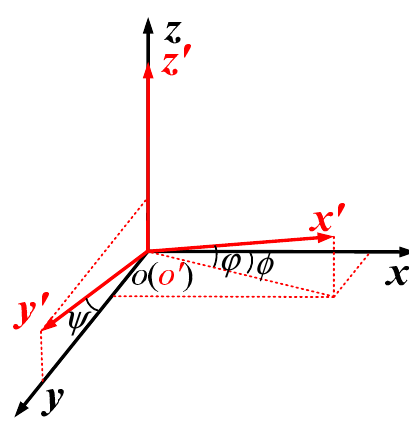
Figure 1. Diagram of the non-orthogonality error.